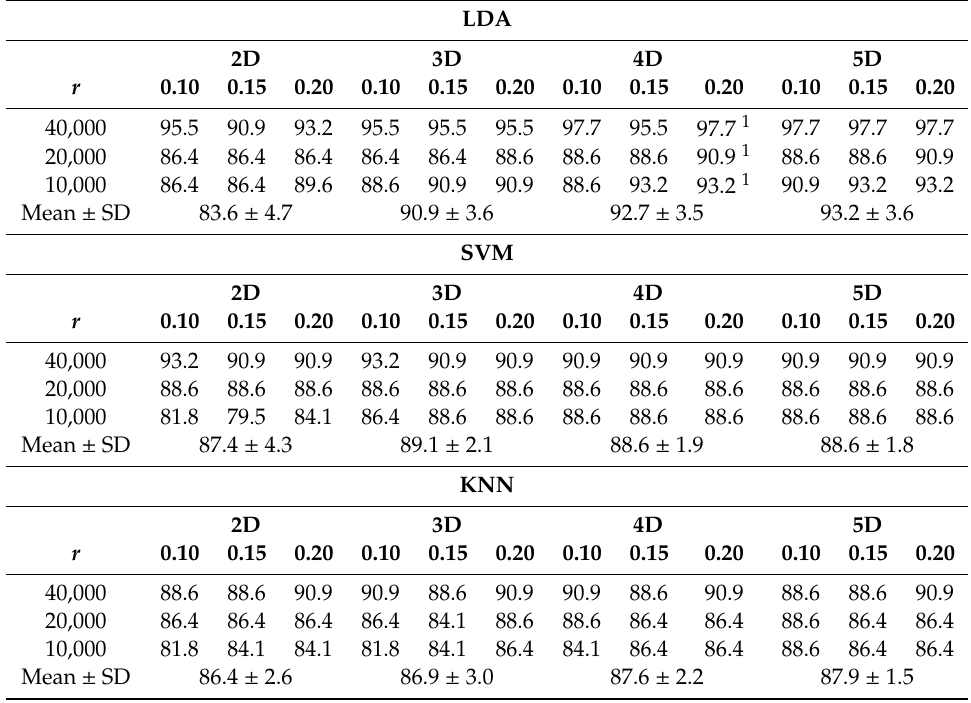
Table 1. Discrimination accuracy between young NSR and CHF participants using linear discriminant analysis (LDA), support vector machine (SVM), and k-nearest neighbor (KNN). Note: SD, standard deviation; 2D, two optimal MSE scales; 3D, three optimal MSE scales; 4D, four optimal MSE scales; 5D, five optimal MSE scales.